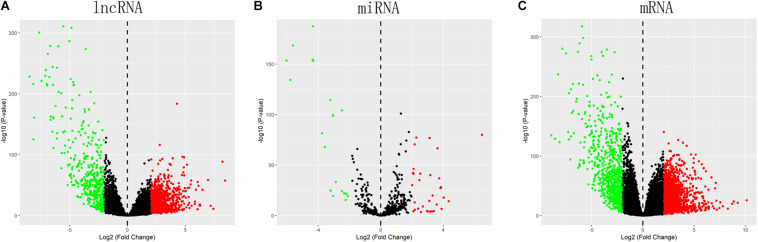
Volcano plots show differential expression of RNAs between KIRC group and control group. (A) DElncRNAs; (B) DEmiRNAs; (C) DEmRNAs. The red color shows the up-regulated lncRNAs, miRNAs, and mRNAs while the green color represents down-regulated lncRNAs, miRNAs, and mRNAs. KIRC: kidney renal clear cell carcinoma. DElncRNAs: differentially expressed lncRNAs; DEmiRNAs: differentially expressed miRNAs; DEmRNAs: differentially expressed mRNAs.